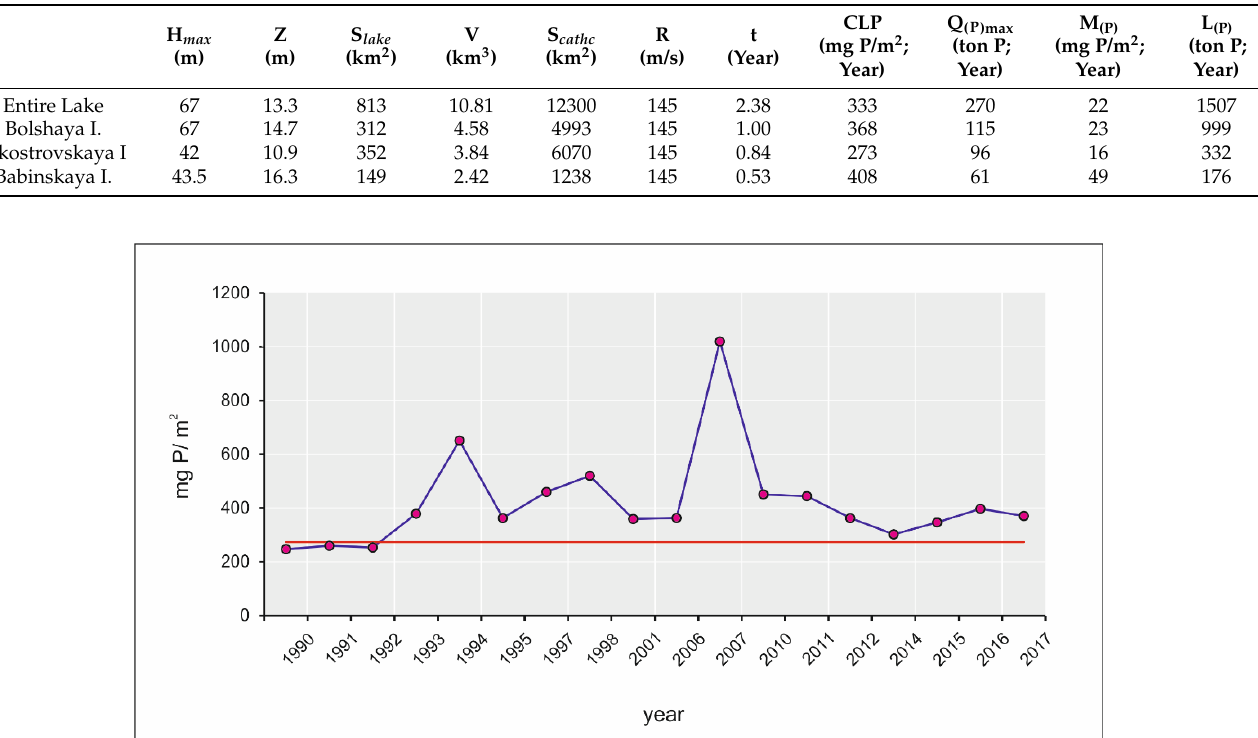
Table 1. The morphometric characteristics and critical and actual annual phosphorus loadings of Lake Imandra and its parts. H max —the maximum lake depth; Z—the average lake depth; S lake —the lake surface area; V—the lake volume; S cathc —the Table 2. Typical recent average values of the physicochemical characteristics of the surface water in various areas of Lake catchment area; R—the water drainage rate; t—the time of water discharge; CLP—critical phosphorus loading; Q (P)max —the Imandra during the summer months. Numerator — median value; denominator — range of values. maximum permissible phosphorus admission to the lake; M (P) —the maximum permissible drainage module of phosphorus; L (P) —annual phosphorous load in 2017.